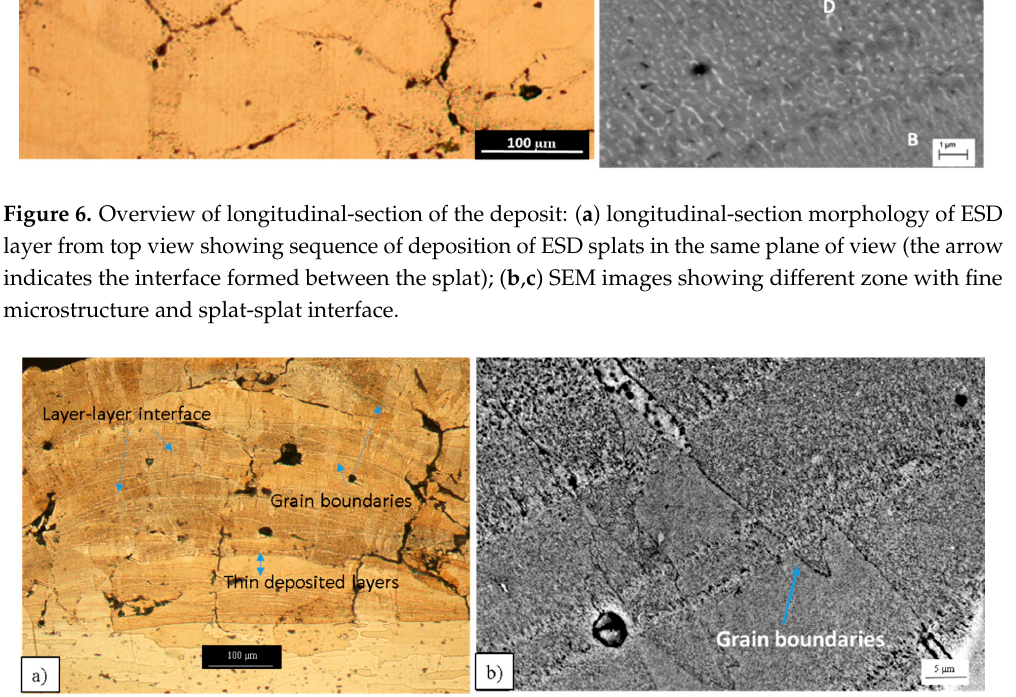
Figure 6. Overview of longitudinal-section of the deposit: ( a ) longitudinal-section morphology of ESD layer from top view showing sequence of deposition of ESD splats in the same plane of view (the arrow indicates the interface formed between the splat), ( b , c ) SEM images showing different zone with fine microstructure and splat-splat interface.